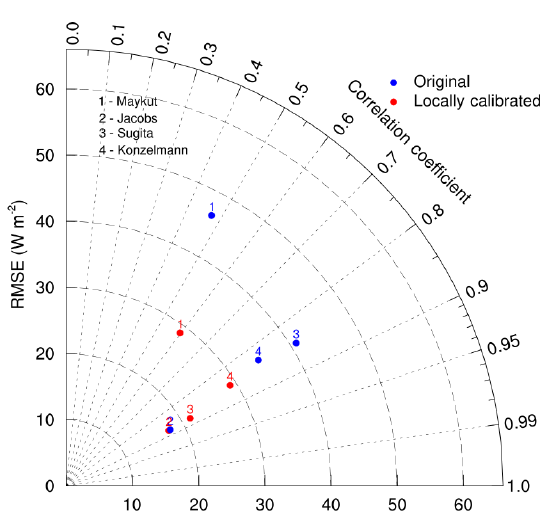
Figure 3. Scatterplots of measured clear-sky DLR data and calcu- lated clear-sky DLR as a function of calculations by Eq. (3) of this study (blue dots) and Eq. (4) by Zhu et al. (2017) (red dots). The dashed black line is the 1 : 1 line.